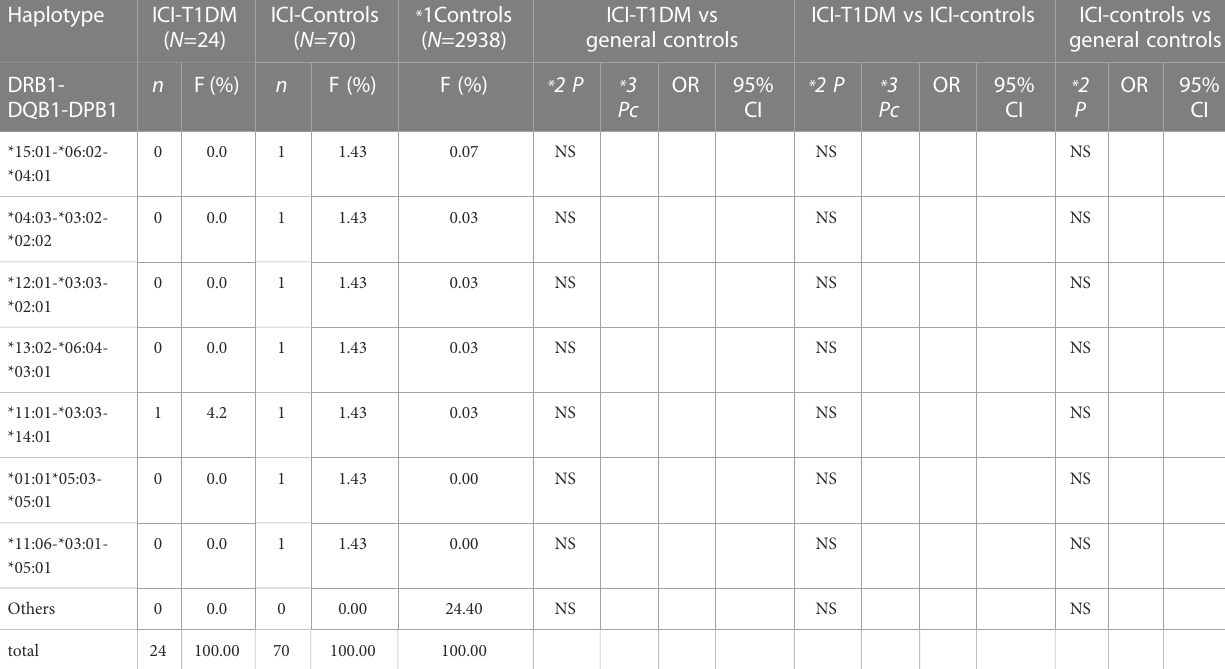
A total of 47 patients with malignancies who had been treated with ICI were subjected to HLA typing by next generation sequencing. T1DM developed in twelve and the remaining thirty- fi ve served as controls. In allele and haplotype analyses, the patients